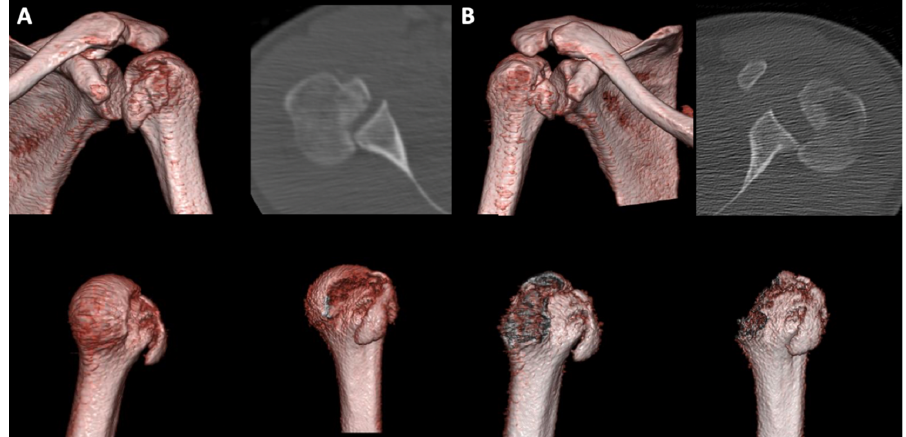
Figure 2. Preoperative imaging of patient from Figure 1; ( A ) preoperative axial CT ‐ scan and 3D ‐ VRT of the left glenohumeral joint; ( B ) preoperative axial CT ‐ scan and 3D ‐ VRT of the right glenohumeral joint.